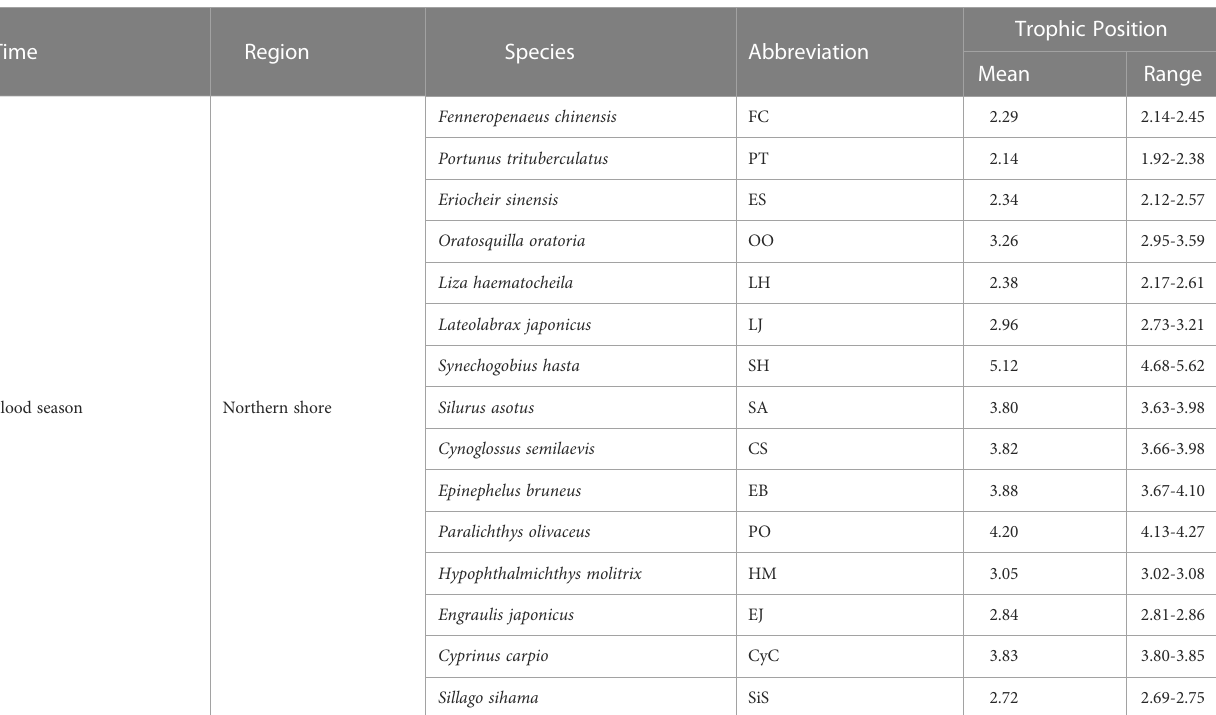
TABLE 1 Trophic positions of dominant species.